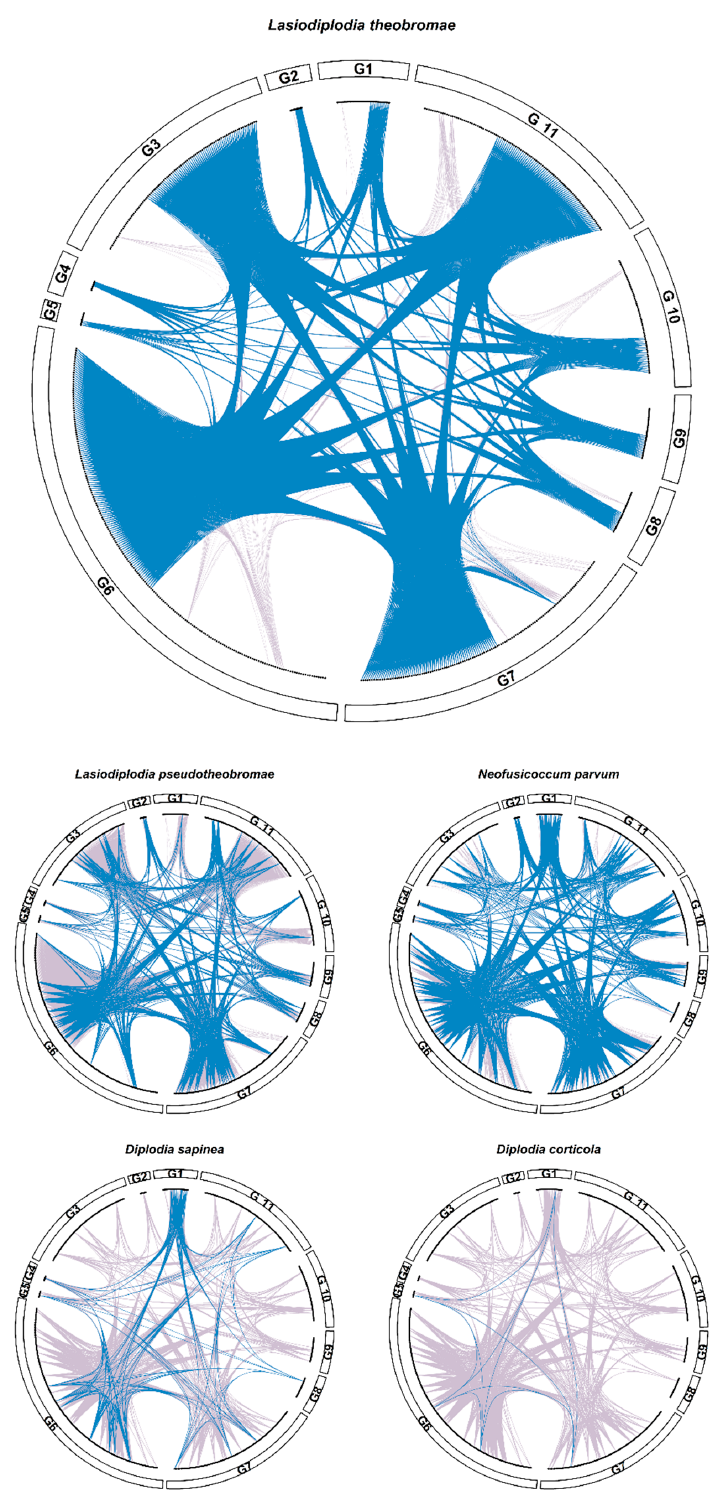
Figure 5. Shared host interactions worldwide based on GenBank and a literature review. Nodes represent hosts genera and are grouped by taxonomic similarity. G1: Pinales and Ginkgoales; G2: Magnoliids; G3: Monocots; G4: Eudicots; G5: Superrosids and Rosids; G6: Fabids; G7: Malvids; G8: Superasterids; G9: Asterids; G10: Campanulids; G11: Lamiids. Lines represent host–fungus interac- tions, where background lines represent all known interactions of the respective Botryosphaeriaceae genus and blue lines represent known interactions of the respective Botryosphaeriaceae